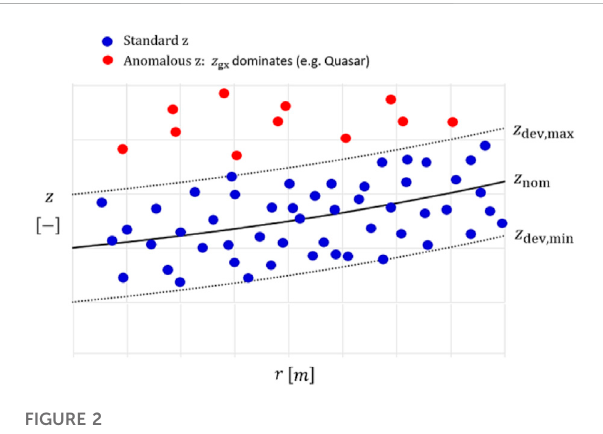
FIGURE 2 Schematization of the cosmological redshift given by the sum of a nominal contribution and a deviating contribution. Red dots represent the anomalous redshift deviating from the standard observational range z dev,max and z dev,min